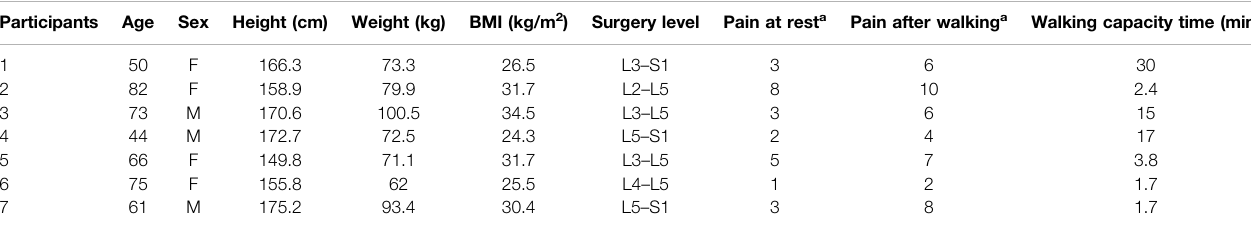
TABLE 1 | Characteristics of the